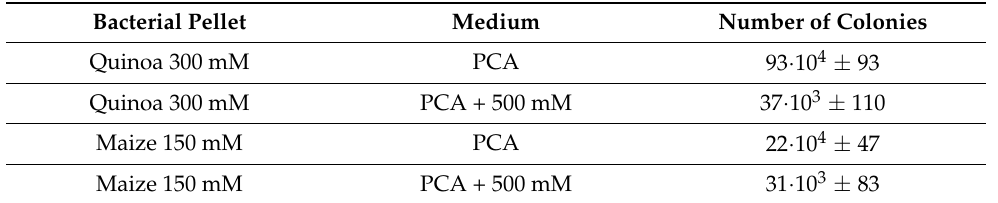
Table 3. Average CFU on control medium (PCA) and on PCA added with salt (PCA + 500 mM) related to the bacteria pellets obtained by quinoa or maize plants irrigated with 300 or 150 mM NaCl solutions, respectively.